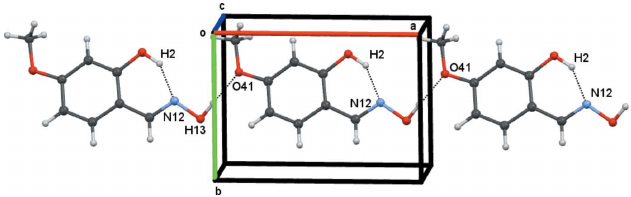
Figure 7 Compound 3 , part of a C 9 chain of molecules formed by O13— H13 (cid:3)(cid:3)(cid:3) O41 hydrogen bonds, propagating along the a- axis direction.